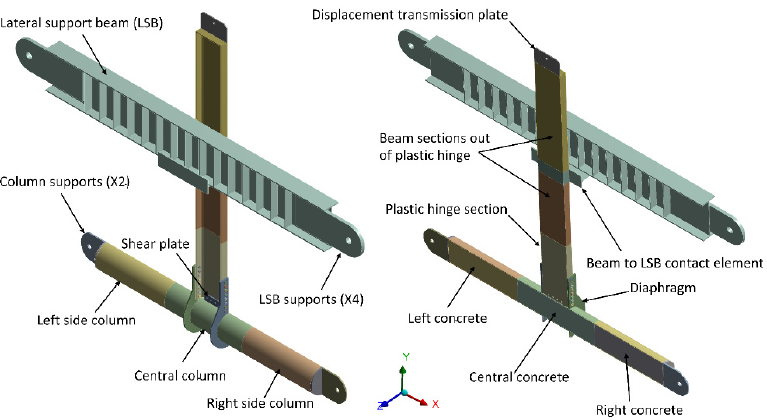
Figure 4. Part division, illustrating the plane of symmetry.